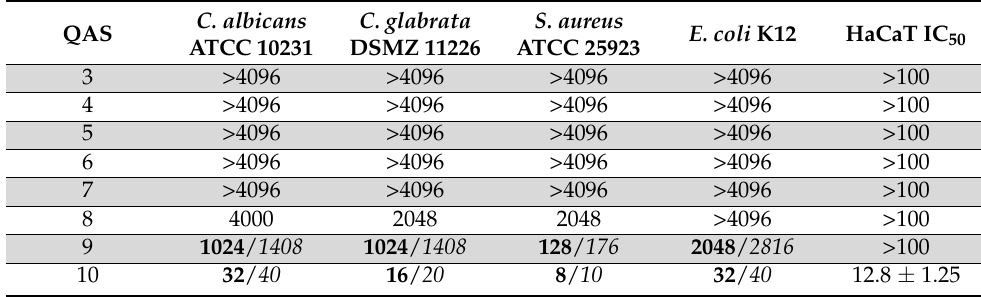
Table 1. Antimicrobial activity-MIC ([ µ g/mL ]/[ µ M] ) and cytotoxicity-IC50 [ µ g/mL] for QAS 3 – 10 . QAS